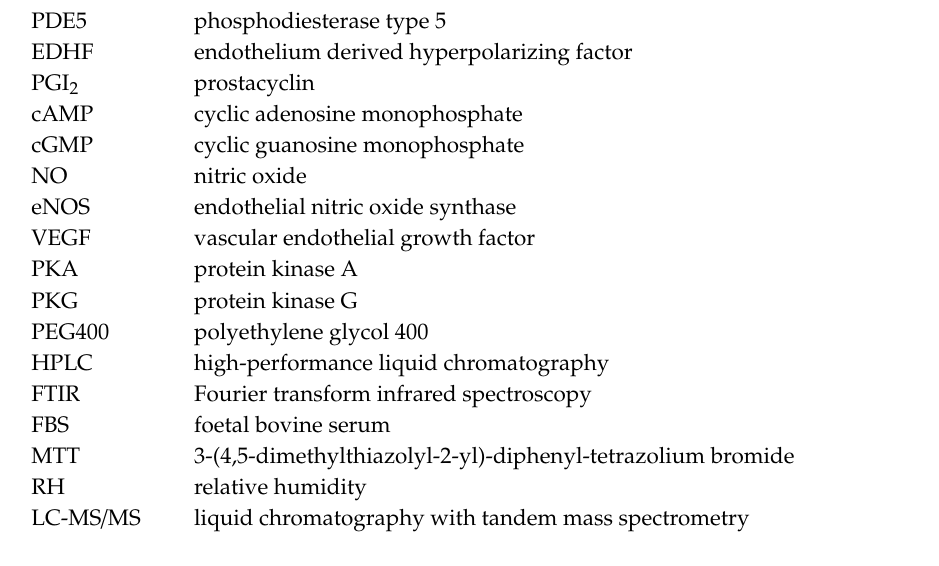
Figure S1: The specificity validation for HPLC analytical method for the quantitation of sildenafil citrate in the microemulsion-loaded hydrogel system. (A) Sildenafil citrate in isopropyl myristate microemulsion-loaded hydrogel system, (B) sildenafil citrate in oleic acid microemulsion-loaded hydrogel system, (C) standard sildenafil citrate spike in the isopropyl myristate microemulsion-loaded hydrogel system, (D) standard sildenafil citrate spike in the oleic acid microemulsion-loaded hydrogel system, (E) placebo in the isopropyl myristate microemulsion-loaded hydrogel system, (F) placebo in the oleic acid microemulsion-loaded hydrogel system, Figure S2 Cell viability in HepG2 cells using the MTT assay after being induced with sildenafil citrate microemulsion-loaded hydrogel for 24 h. Data are shown as mean ± SD of triplicate assays. Figure S3: Amount of sildenafil citrate accumulation in the cell after incubation for 6 h, Figure S4: LC-MS / MS chromatogram of (A) sildenafil citrate, (B) drug extraction from cells incubated in sildenafil citrate aqueous solution for 6 h, (C) drug extraction from cells incubated in the sildenafil citrate microemulsion-loaded hydrogel (IPM system) for 6